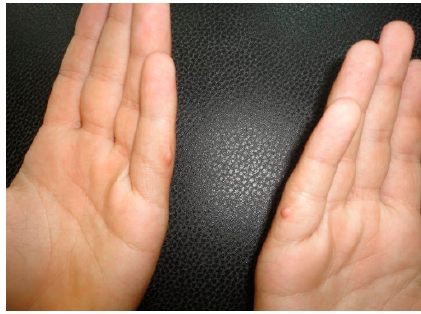
Figure 4. Bilateral trichoepitheliomas on the lateral aspect of the 5th digits.